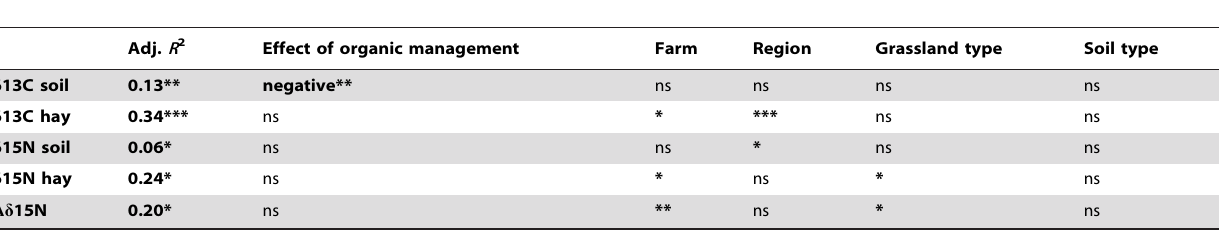
Table 1. Summary of multiple ANOVA models of isotopic abundances (no interaction with management was significant) ( n =55). ‘‘Grassland type’’ = pasture, meadow or mown pasture. a